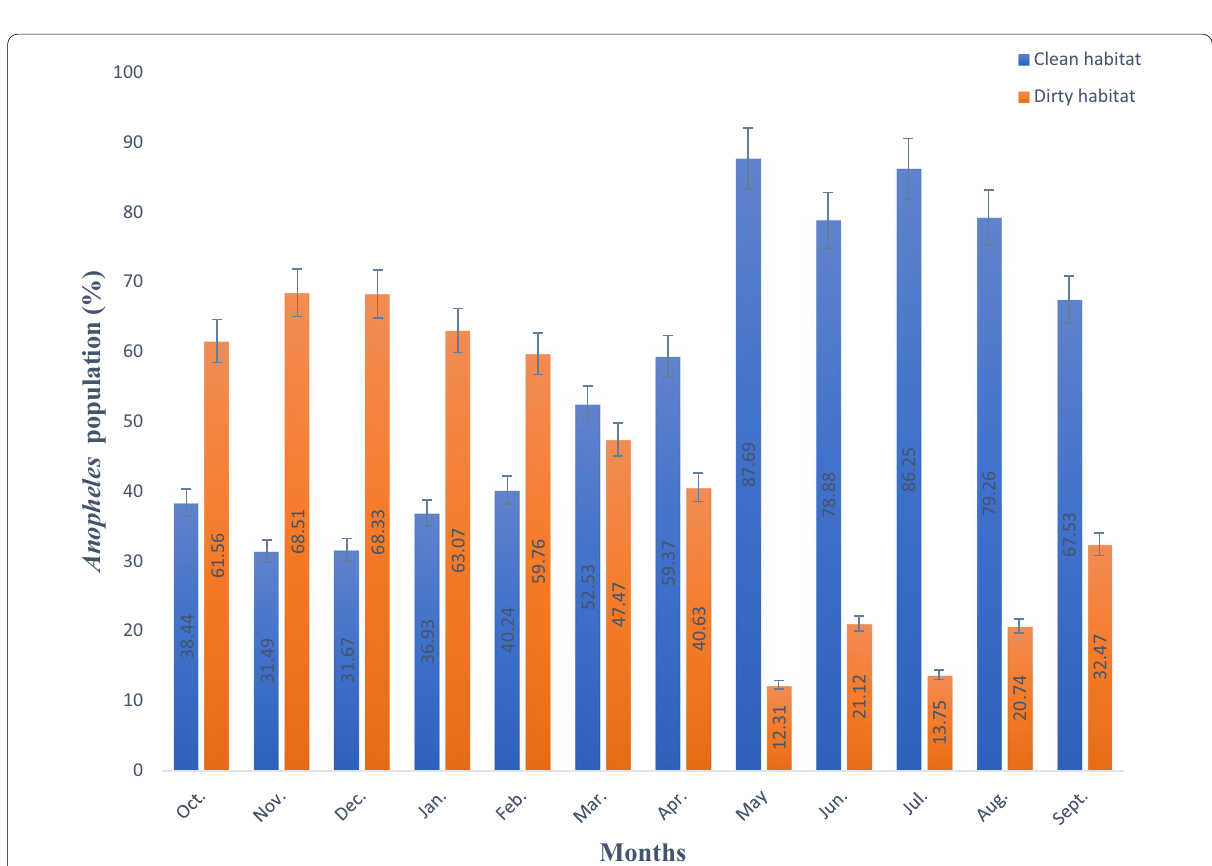
Fig. 2 Monthly distribution of Anopheles larvae and pupae in relation to habitat nature